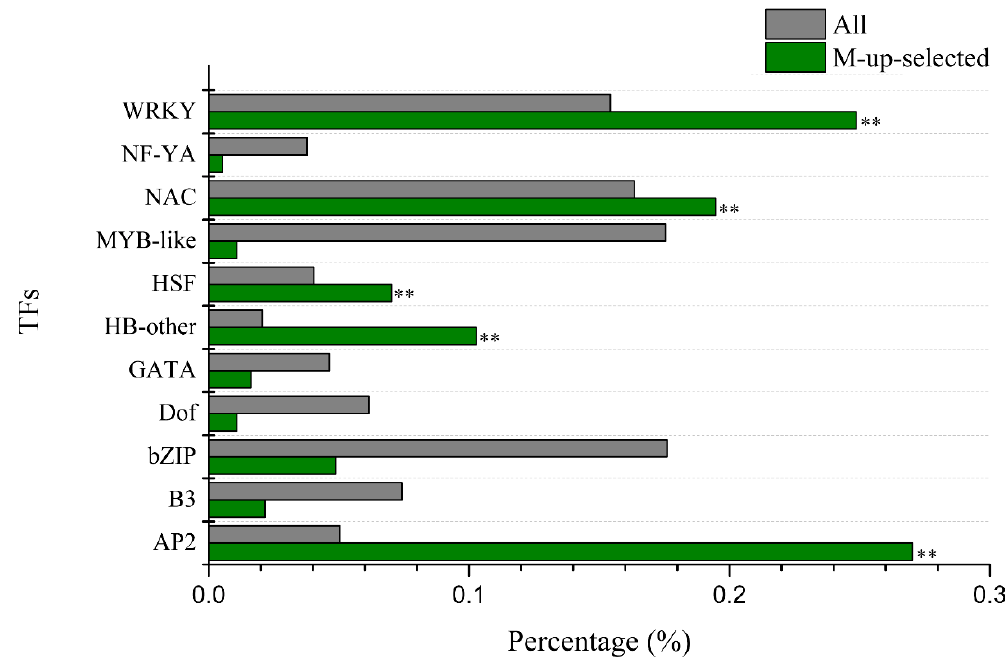
Figure 4. Enrichment of the transcription factor (TF) families among the M-up-selected genes. The percentage of TF families in M-up-selected genes and all TFs in soybean genome was shown as green bars and grey bars, respectively. ** indicate significant enrichment at 0.01 level.